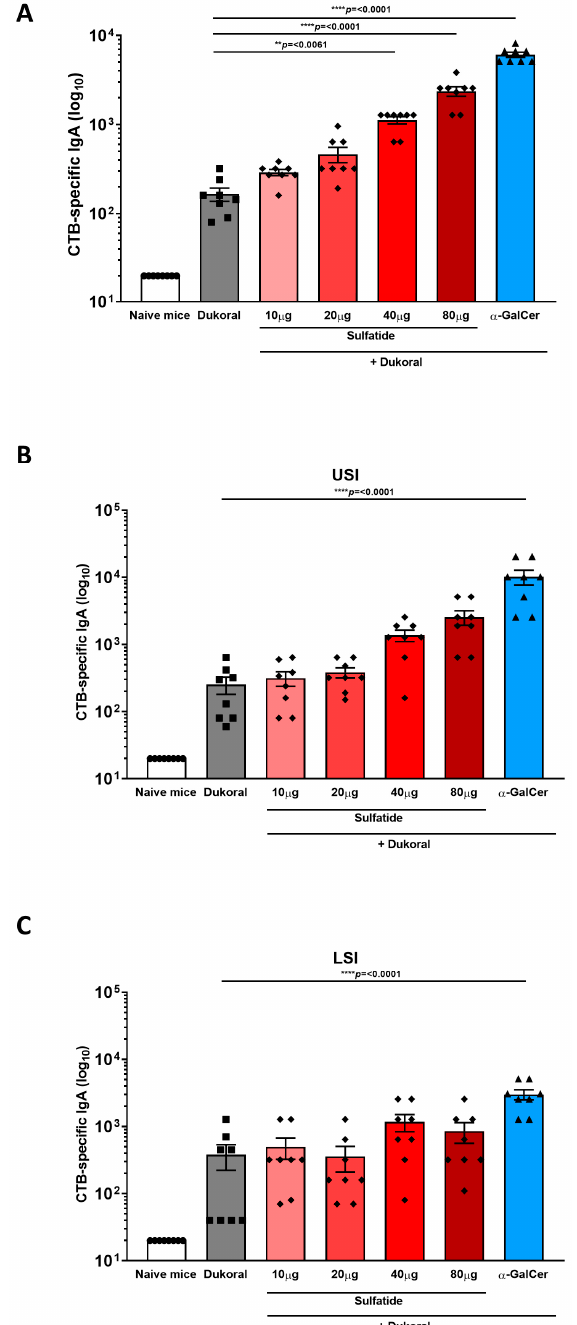
Figure 1. Sulfatide enhances intestinal cholera toxin subunit B-specific IgA responses following oral co-administration with Dukoral ® . Female C57BL/6 mice were immunised orally with Dukoral ® co-administered with 10, 20, 40 or 80 µ g sulfatide, or 10 µ g α -GalCer in comparison with mice immunised with Dukoral ® alone or with PBS (naïve mice). On day 42 and 43, faecal pellets and intestinal tissues were collected, respectively. Endpoint titres of CTB-specific IgA in faecal pellets ( A ), upper small intestine (USI) ( B ) and lower small intestine (LSI) ( C ) were determined by ELISA. Results presented are mean titres ± SEM. Significant differences between the group of mice vaccinated with Dukoral ® alone and Dukoral ® co-administered with an oral adjuvant are shown. Symbols show the groups of mice. Circles: naïve mice. Squares: mice immunised with Dukoral ® alone. Rhombus: mice immunised with Dukoral ® and sulfatide. Triangles: mice immunised with Dukoral ® and α -GalCer. Each symbol represents one animal in the